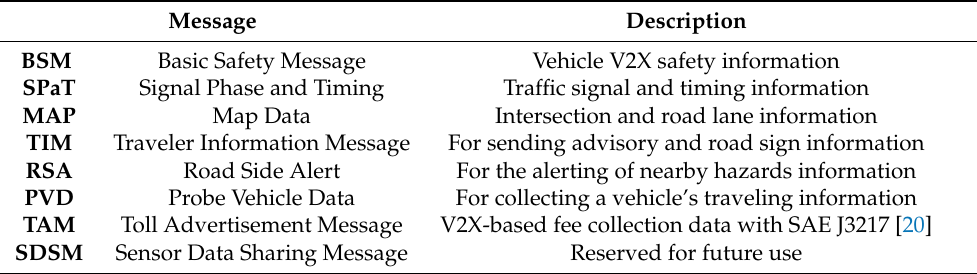
Table 1. The main message set of SAE